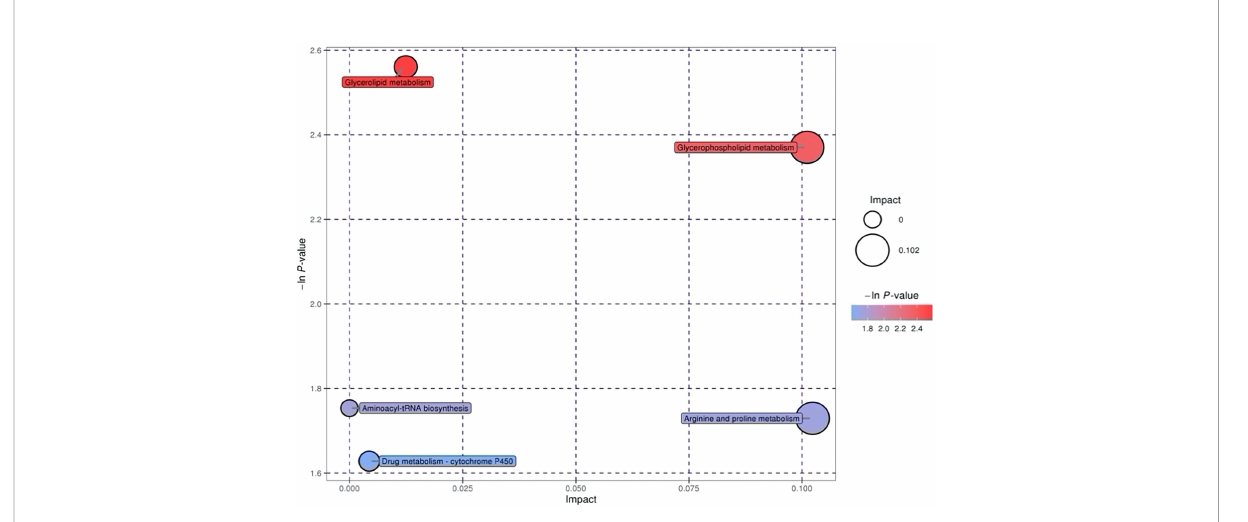
FIGURE 1 Metabolic pathways relevant to the follicular fl uid.